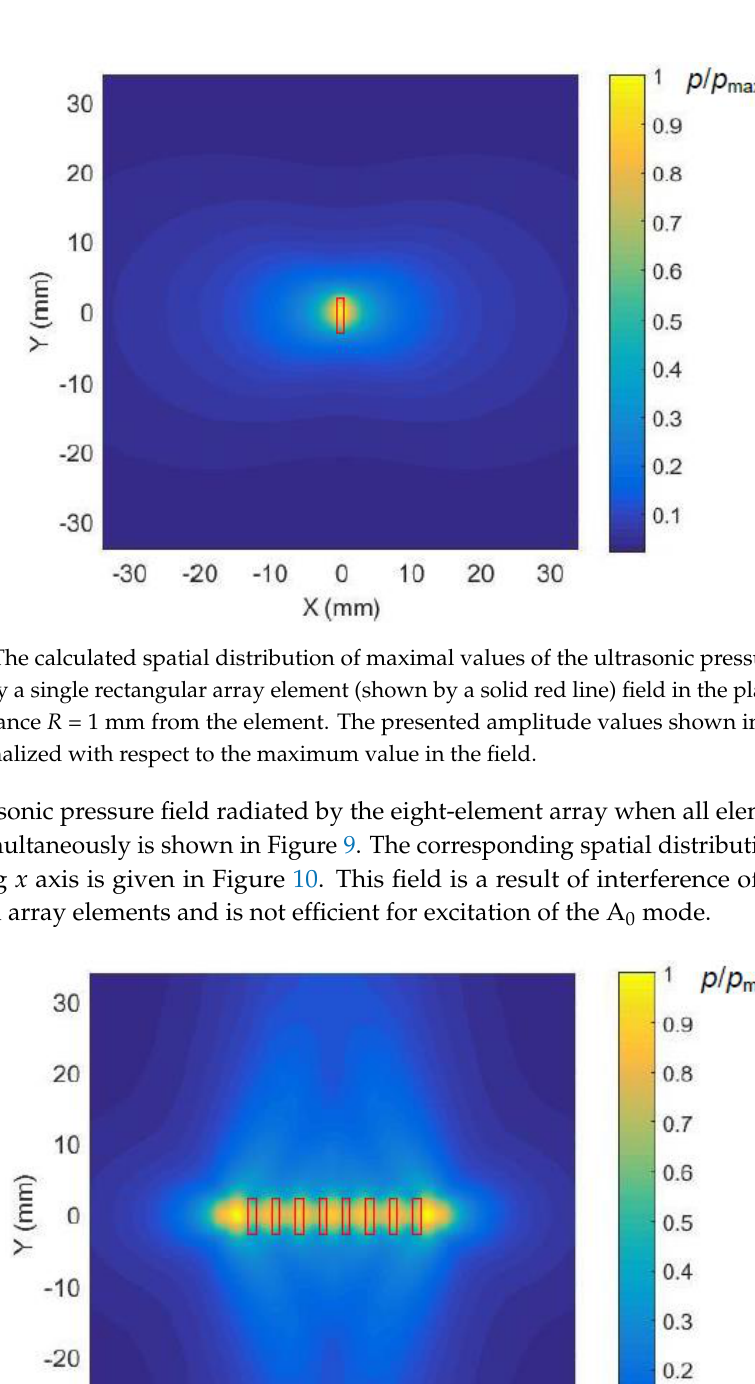
Figure 7. Calculated waveforms of the incident ultrasonic pressure pulses in the plane of the plastic film (z = 1 mm) at different distances from the piezo element symmetry axis: ( a ) schematic diagram showing propagation directions of ultrasonic pulses; ( b ) x = 0 mm (piezo element centre); and ( c ) x = 35 mm.